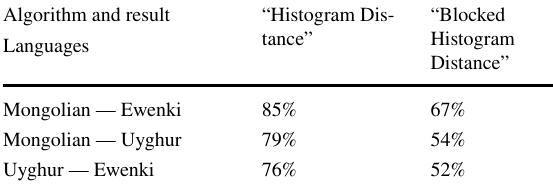
Note : image similarity comparison based on Fig.